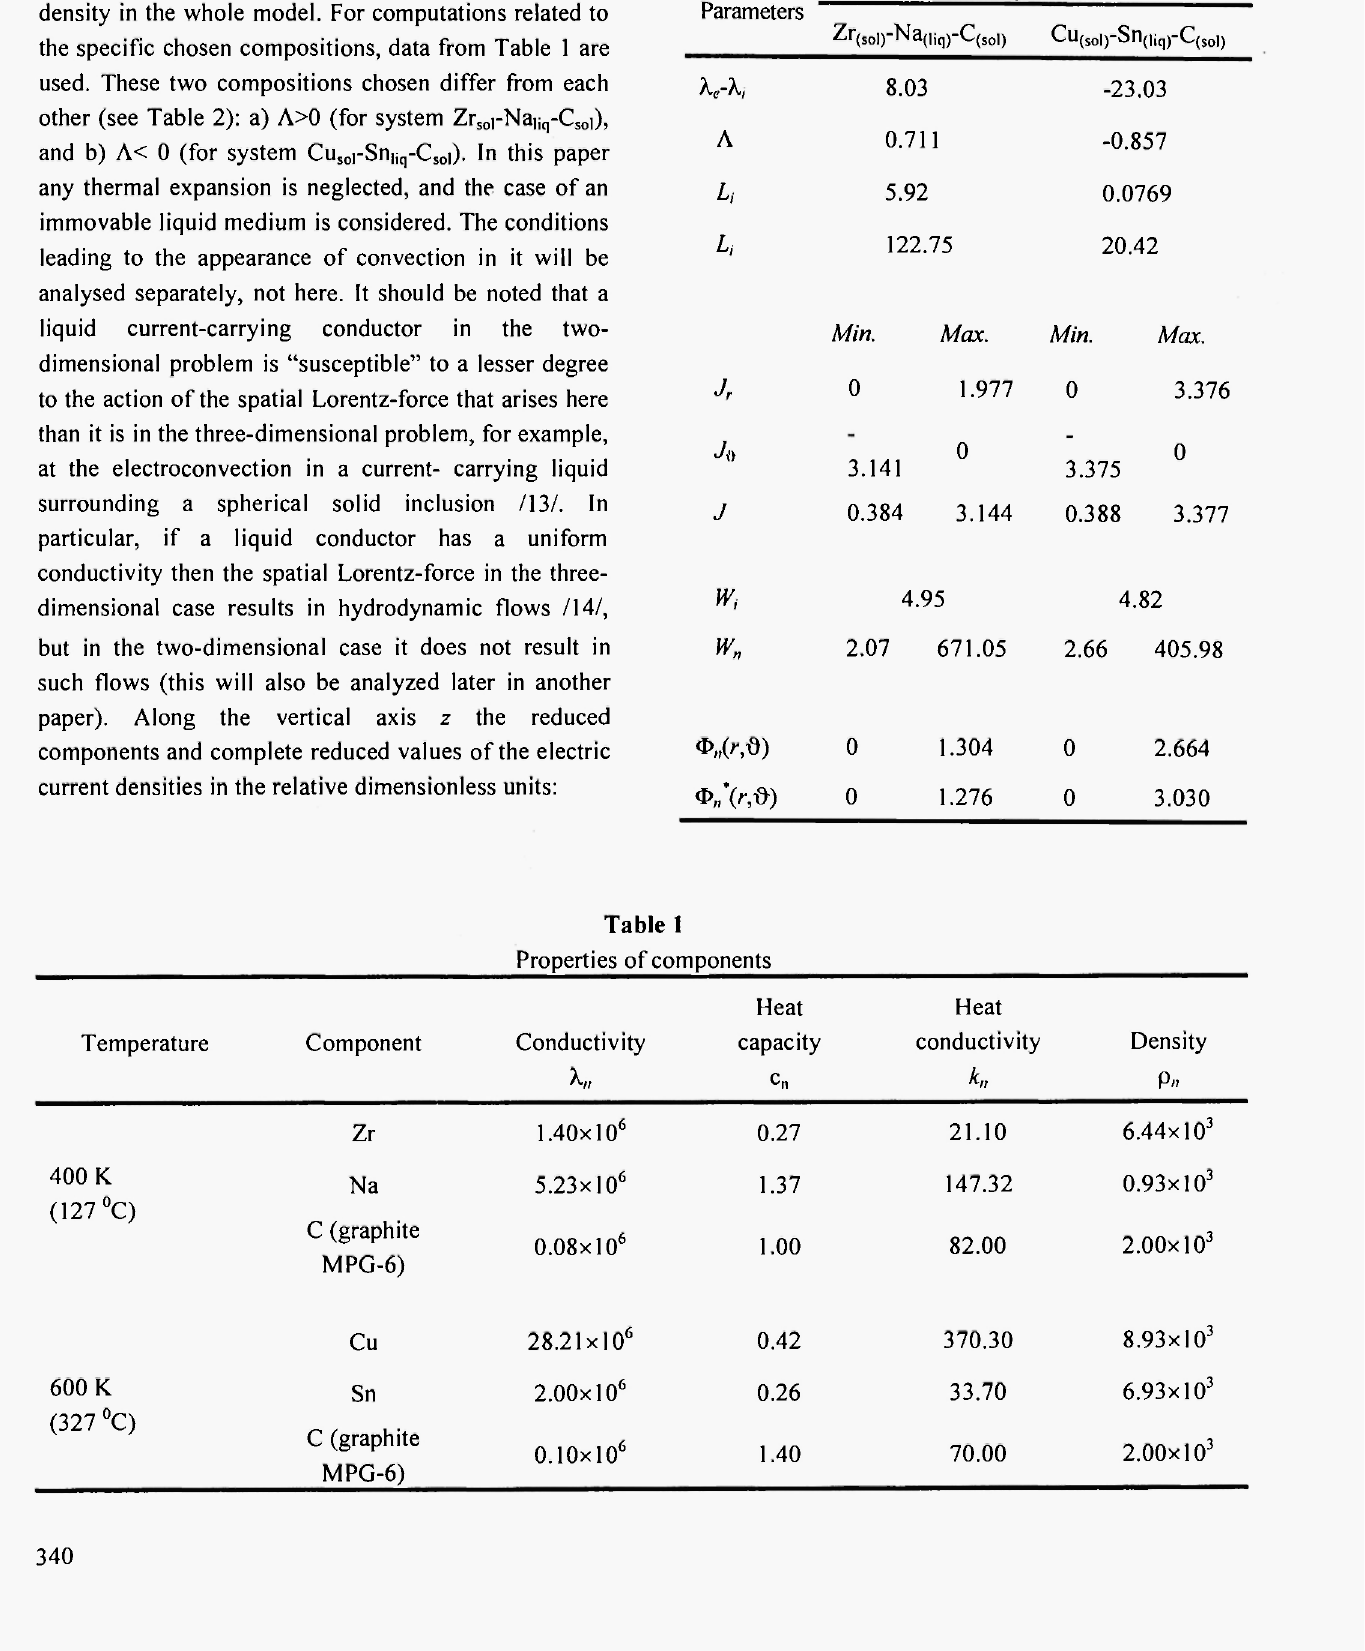
Numerical values of parameters of equations System